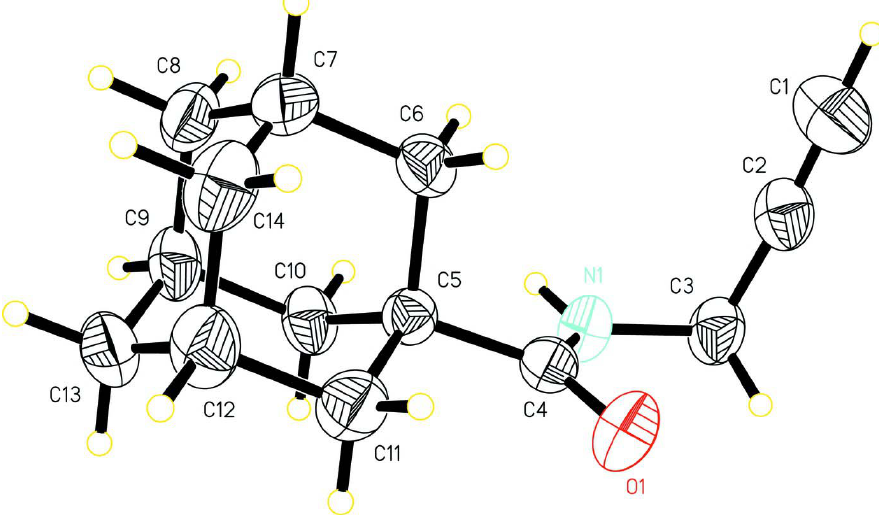
Perspective view of the title compound with atom numbering. Displacement ellipsoids are at the 50% probability